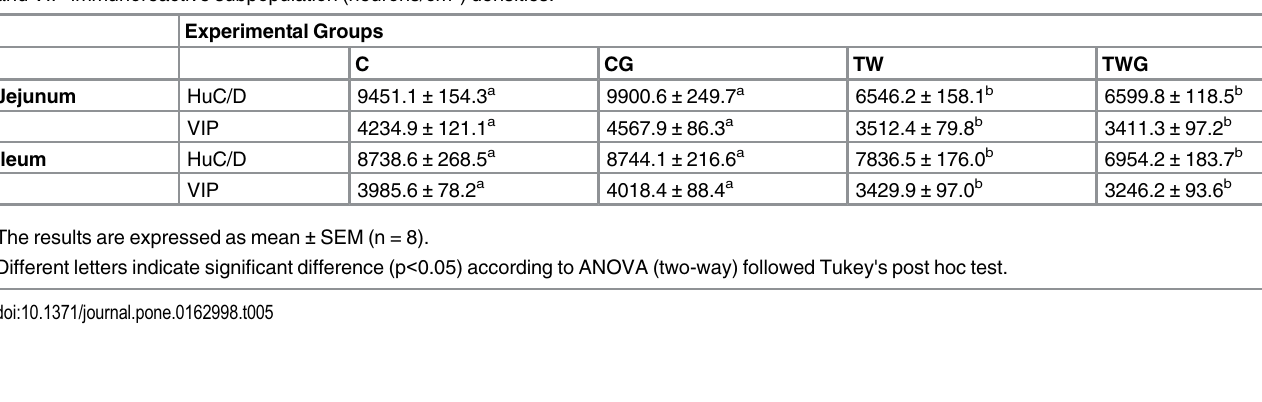
Table 5. Neuronal density of submucous neurons (neurons/cm 2 ) in the jejunum and ileum. Experimental groups: control (C); control supplemented with 2% L-glutamine (CG); Walker-256 tumor (TW); and Walker-256 tumor supplemented with 2% L-glutamine (TWG). HuC/D-IR population (neurons/cm 2 ) and VIP-immunoreactive subpopulation (neurons/cm 2 ) densities.